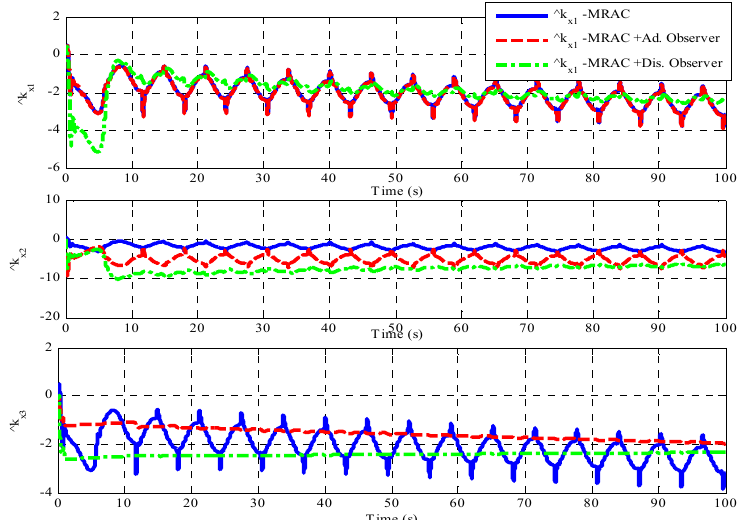
Figure 4. Exoskeleton knee assisted system speed response for the three controllers.